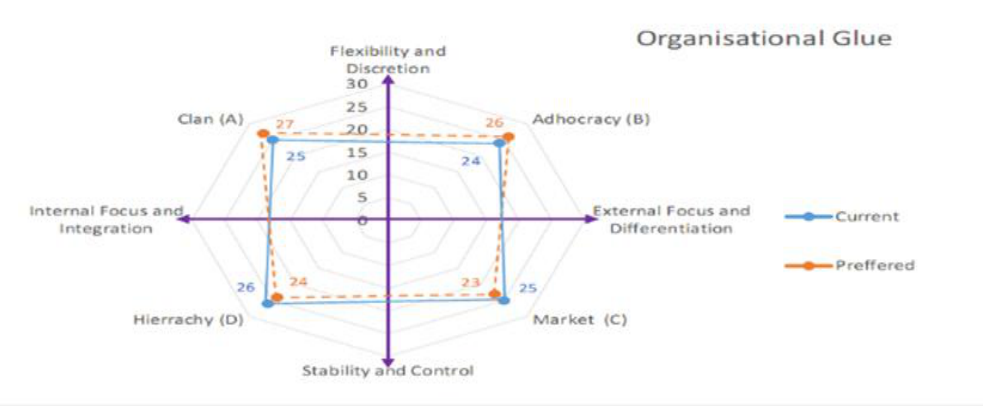
Figure 7. Radar diagram of dimension of organizational glue